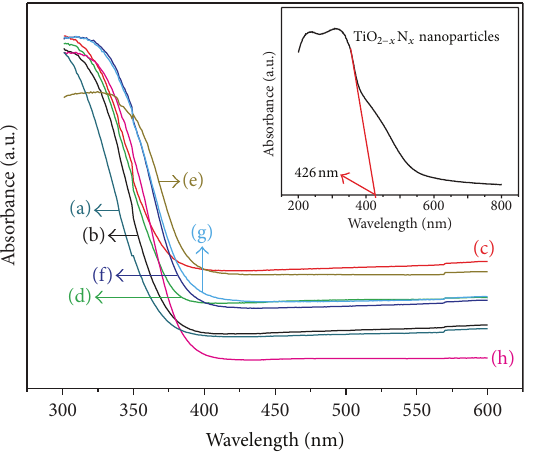
Figure 4: UV-vis absorption spectra of the uncalcined ((a): 0%; (b): 1%; (c): 2%; (d): 5%) and calcined ((e): 0%; (f): 1%; (g): 2%; (h): 5%) samples with different Sr/Ti ratios.